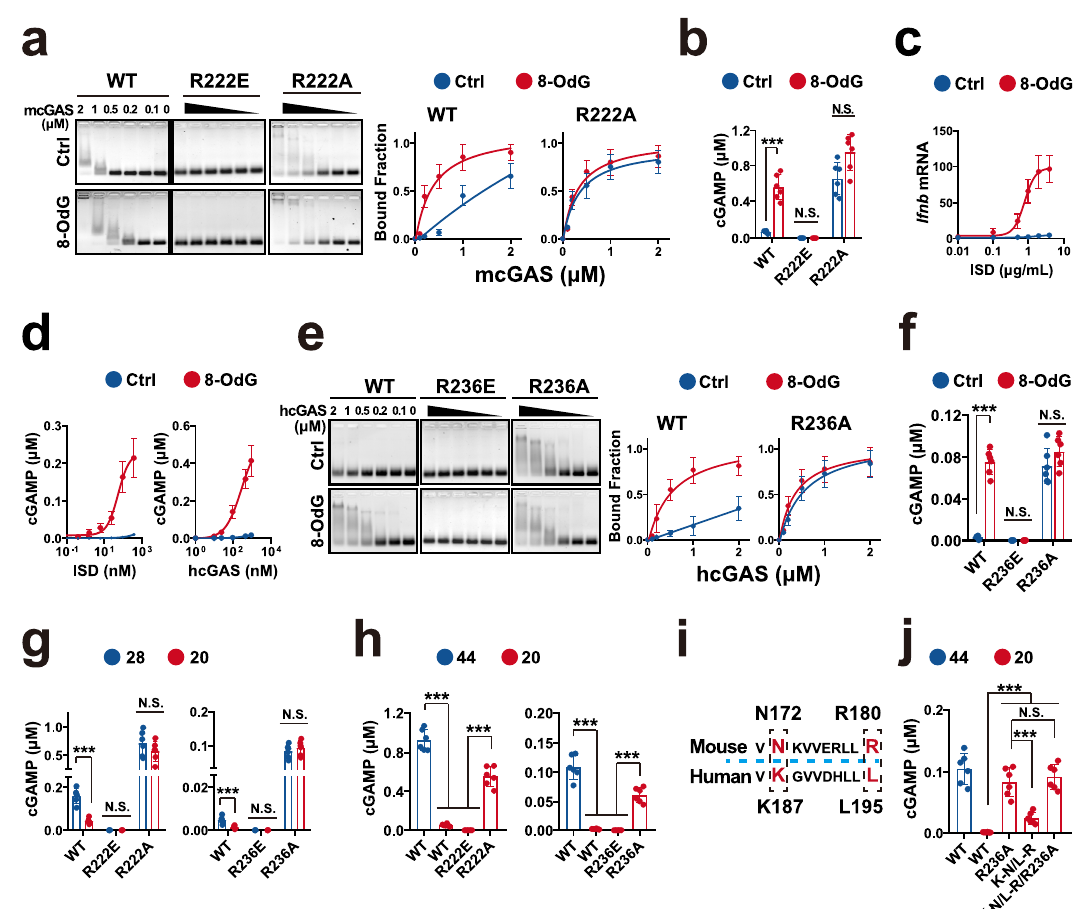
Fig. 5 | Human R236 substitution relaxes the DNA-length speci fi city of cGAS. a EMSA analyses of 50nM 20bp ISDs binding the noted mouse mcGAS proteins. Mean±SD. n =3 independent experiments. b cGAMP produced by mixing 100nM noted mcGAS and 100nM 20bp noted ISD for 2h. Unless speci fi cally noted, P values were from unpaired two-tailed Student ’ s t test without adjustment for multiple comparisons (*** p <0.001, ** p <0.01, * p <0.05, N.S.=not statistically sig- ni fi cant( p >0.05))inthisstudy.Mean±SD. n =6biologicallyindependentsamples. c Ifnb mRNA levels in the human THP-1 cells transfected with 100ng/mL 20bp noted ISDs for 2h. Mean±SD. n =3 biologically independent samples. d Left: cGAMP produced by 100nM human hcGAS in serial dilutions of noted ISD for 2h. Right: cGAMP produced by serial dilutions of human hcGAS in 100nM noted ISD for 2h. Mean±SD. n =3 biologically independent samples. e EMSA analyses of